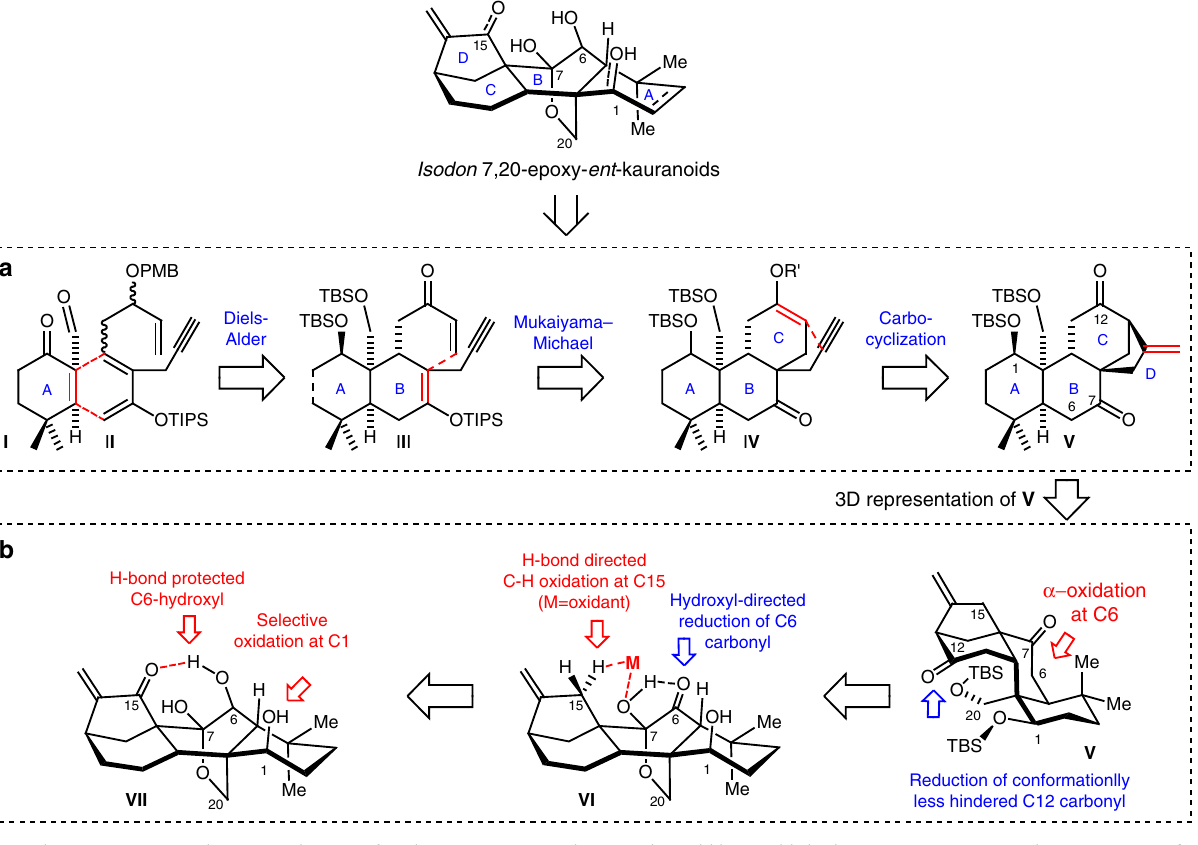
Fig. 2 Synthetic strategies. a The tetracyclic core of Isodon 7,20-epoxy- ent -kauranoids could be established via an iterative ene-cyclization strategy. b The appropriate oxygenation could be installed via a site-selective oxidation and reduction sequence via a conformation and hydrogen-bond-guided redox –